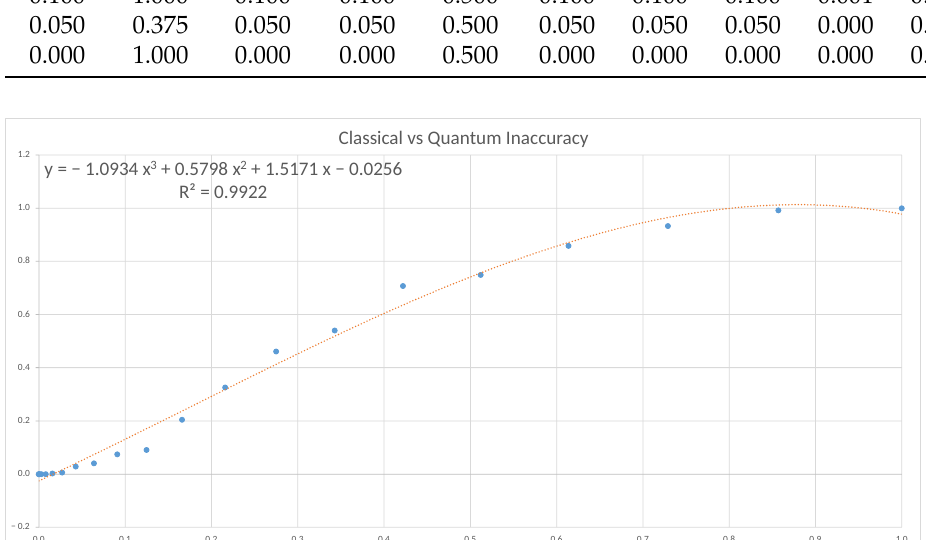
Figure 16. Plot of the results obtained for the imprecision and uncertainty